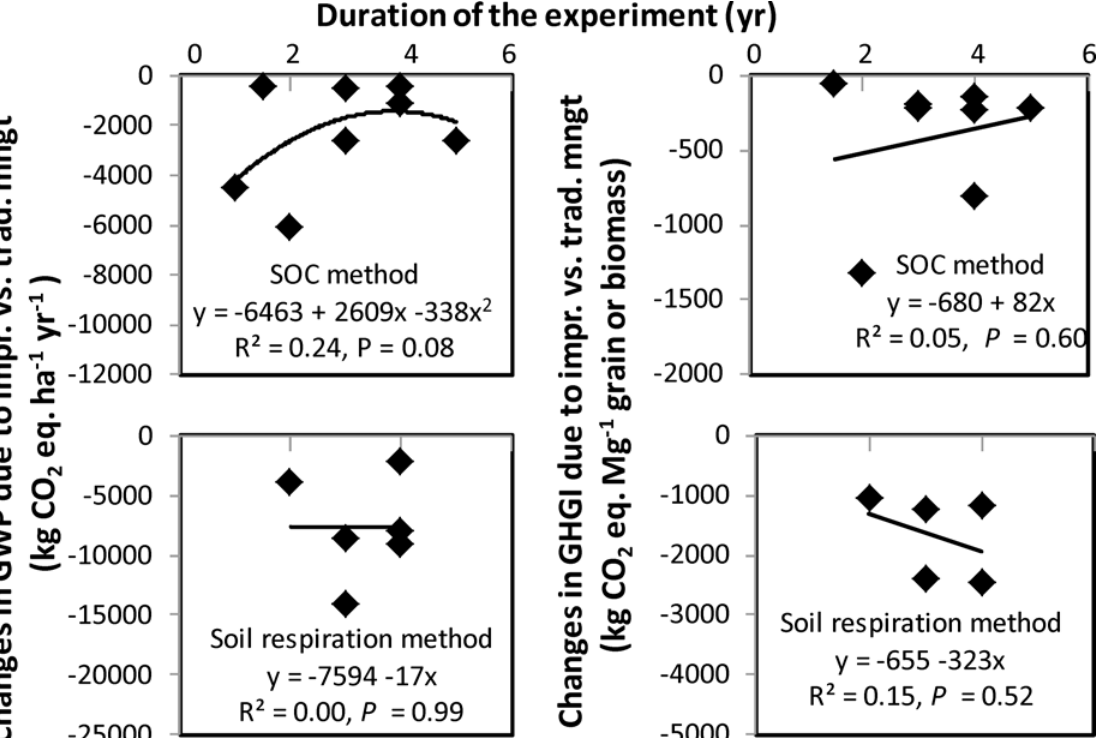
Fig 5. Changes in net global warming potential (GWP) and greenhouse gas intensity (GHGI) due to improved vs. traditional management practice with the duration of the experiment using the soil organic C and soil respiration methods. Because of the lack of sufficient data, only the all data option method of calculating GWP and GHGI were used for